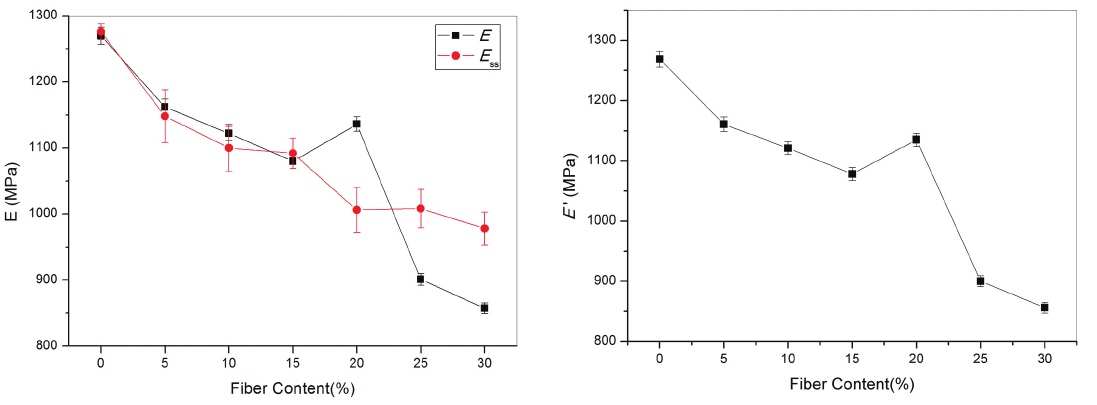
Figure 7. Storage modulus as a function of coconut fiber content.